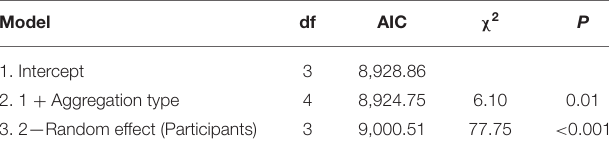
TABLE 1 | Linear mixed model results for landscape preference as a function of aggregation type (dispersion vs. interspersion).